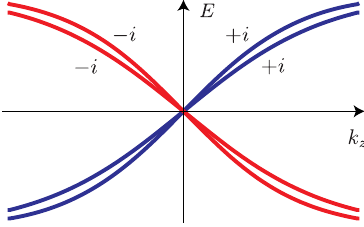
FIG. 3. The two pairs of counterpropagating Dirac bands along the k axis distinguished by eigenvalues of C 2 ¼ (cid:2) i z